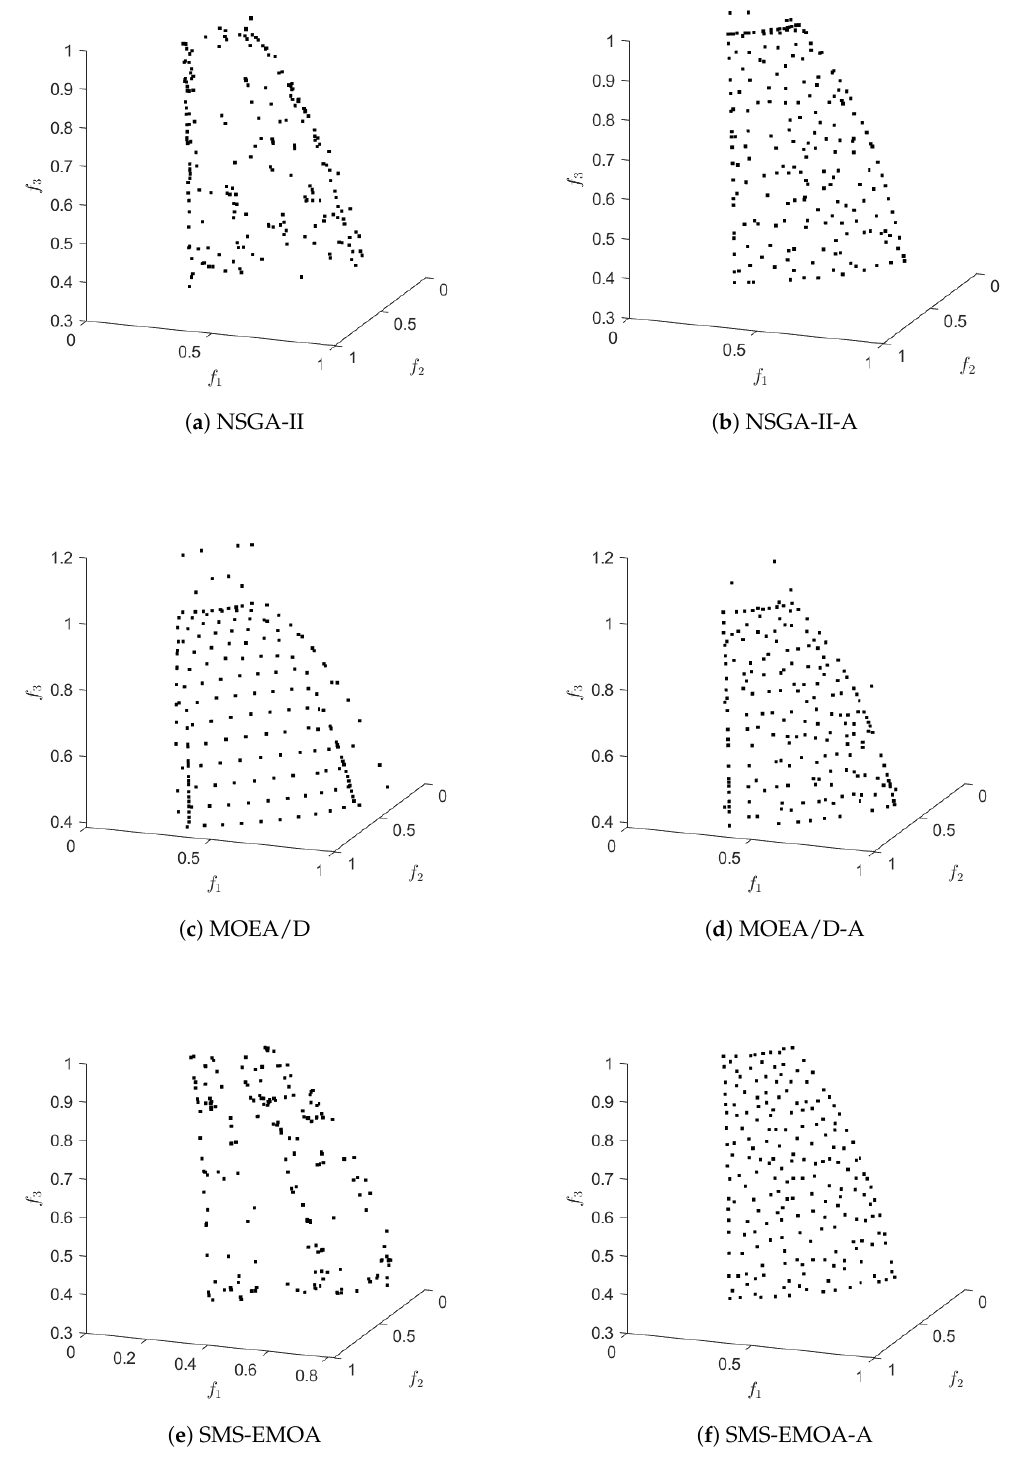
Figure A6. Numerical results of the different algorithms and archiving/selection strategies on MaF2 for k =